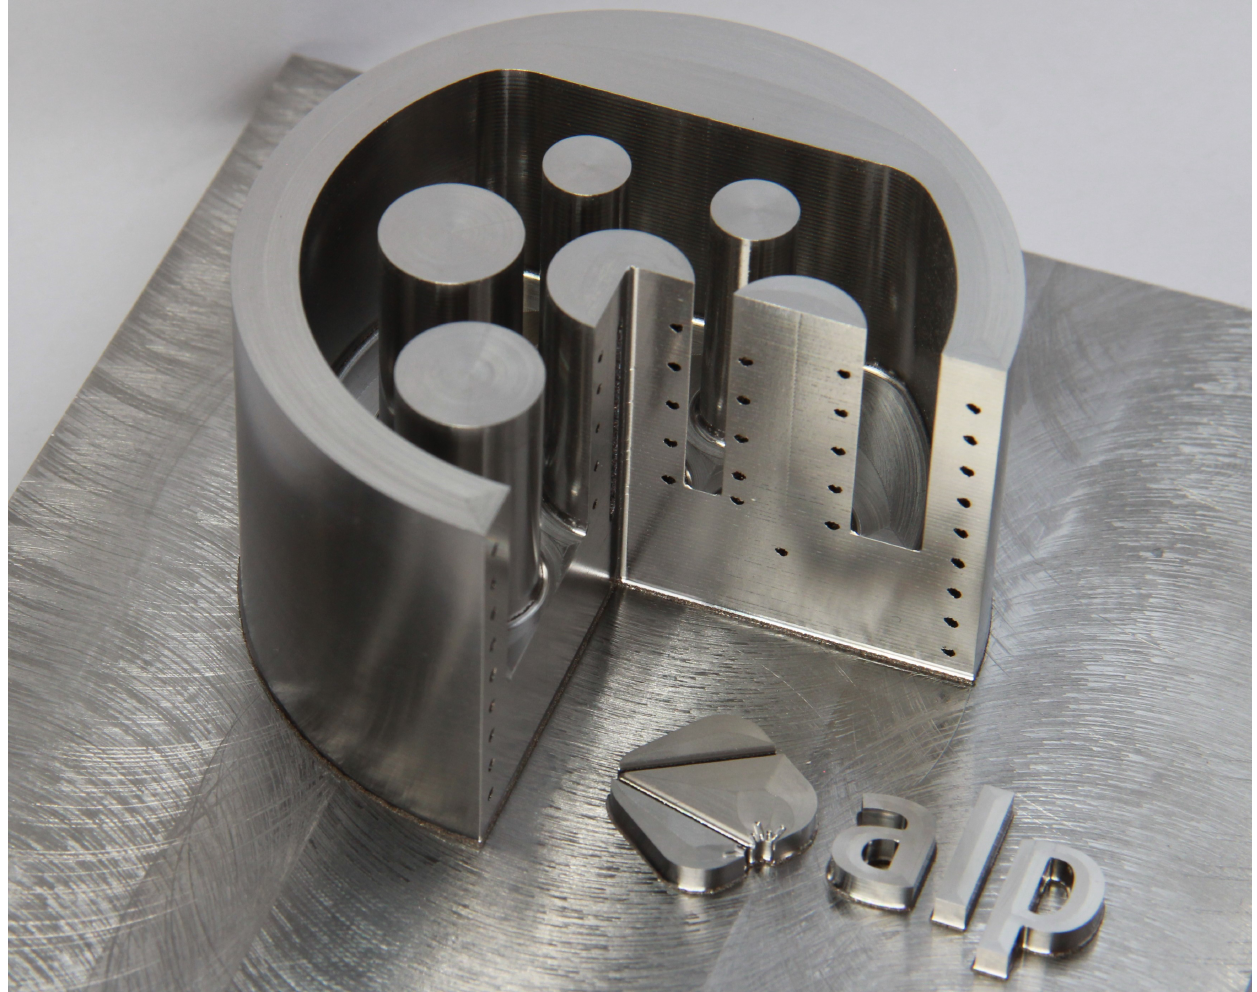
Figure 19. Injection mold of a charge socket for an electro mobile with a spared part, confirming the conformal